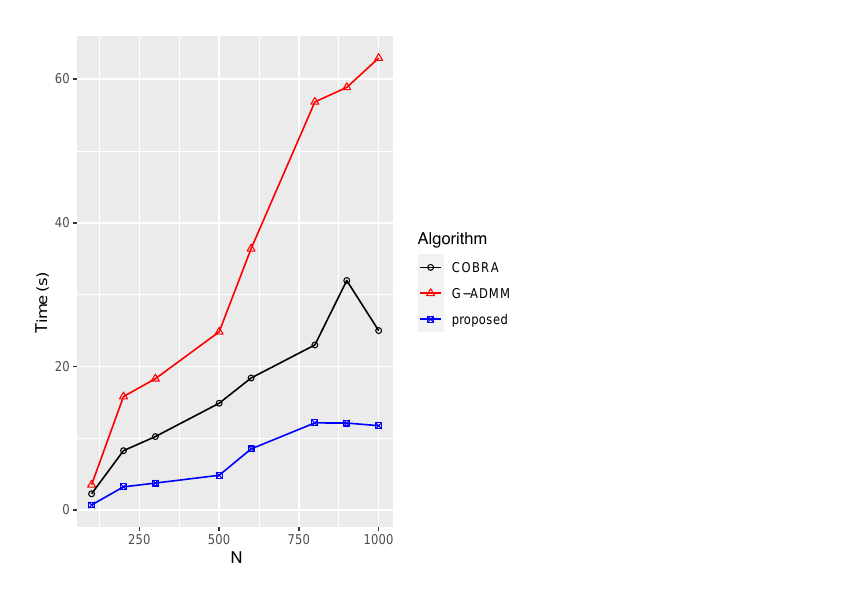
Figure 3. Execution times for each N with λ = 1, p = 40 and (cid:101) = 1 × 10 − 6